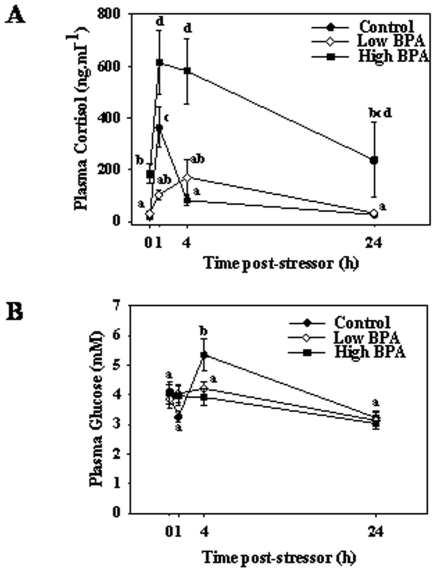
Impact of bisphenol A (BPA) on the organismal stress response.Effect of BPA exposure on stressor-induced plasma cortisol (A) and glucose concentrations (B) in juvenile rainbow trout (400-dpf). Plasma samples were collected at 0 (prior to stress), 1, 4 and 24 h after a handling disturbance. See Fig. 2 legend for details. All values represent mean ± SEM (n = 8 fish); time points with different letters are statistically significant (Two-way ANOVA; p<0.05).